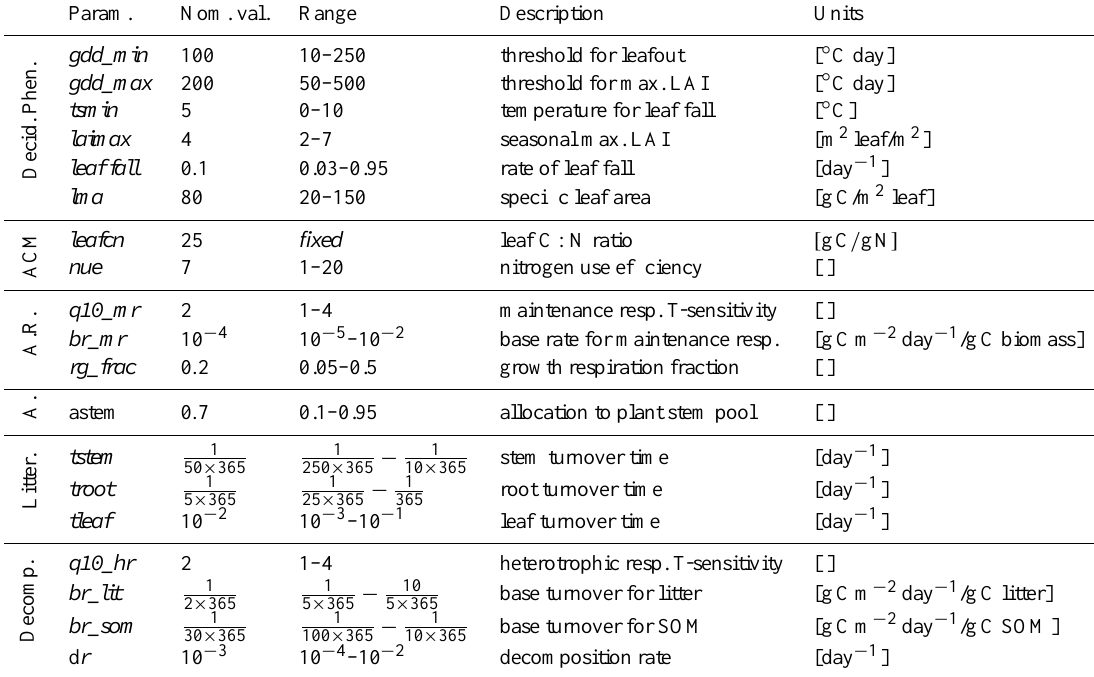
Table 1. Description of model parameters.